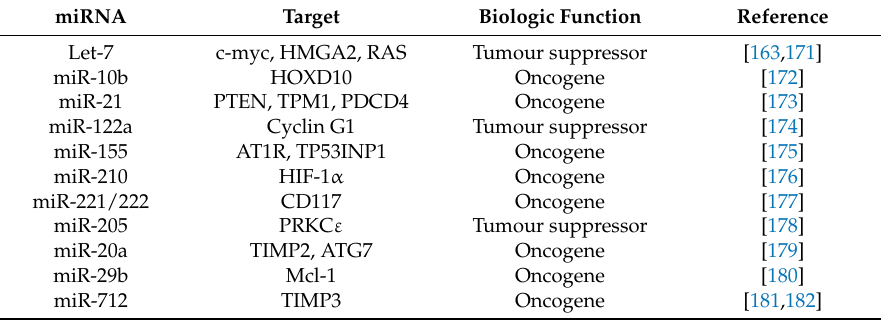
Table 2. Representative miRNAs involved in cancer diseases and covered in this review.